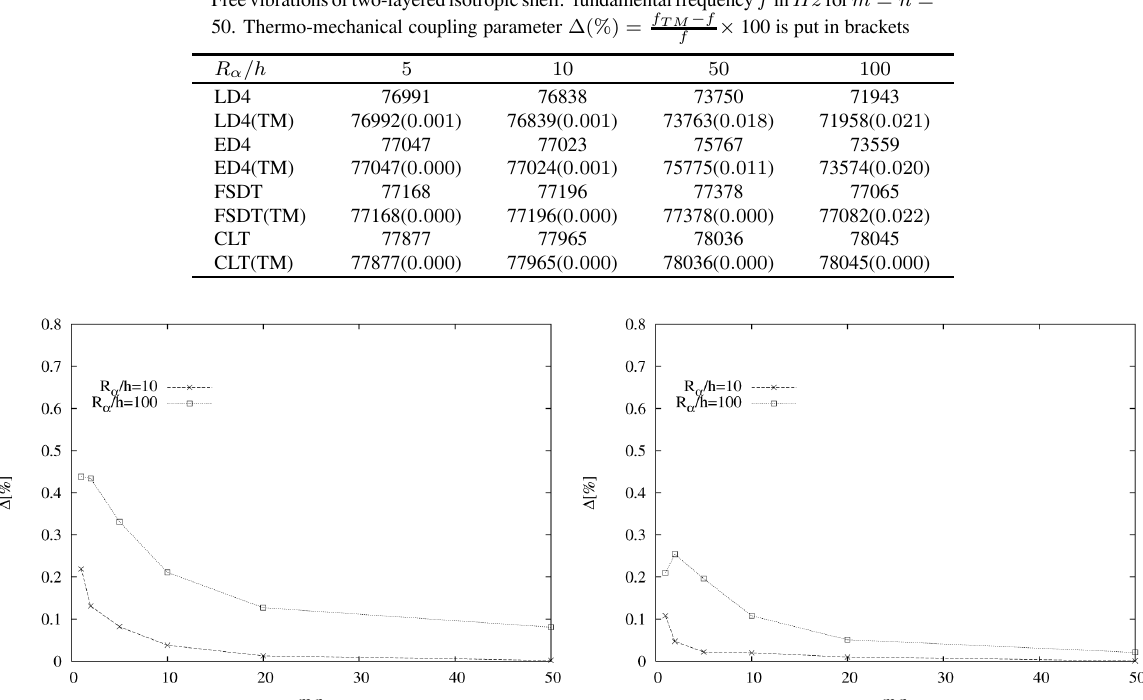
Table 7 Freevibrationsoftwo-layeredisotropicshell: fundamentalfrequency f in Hz for m = n =